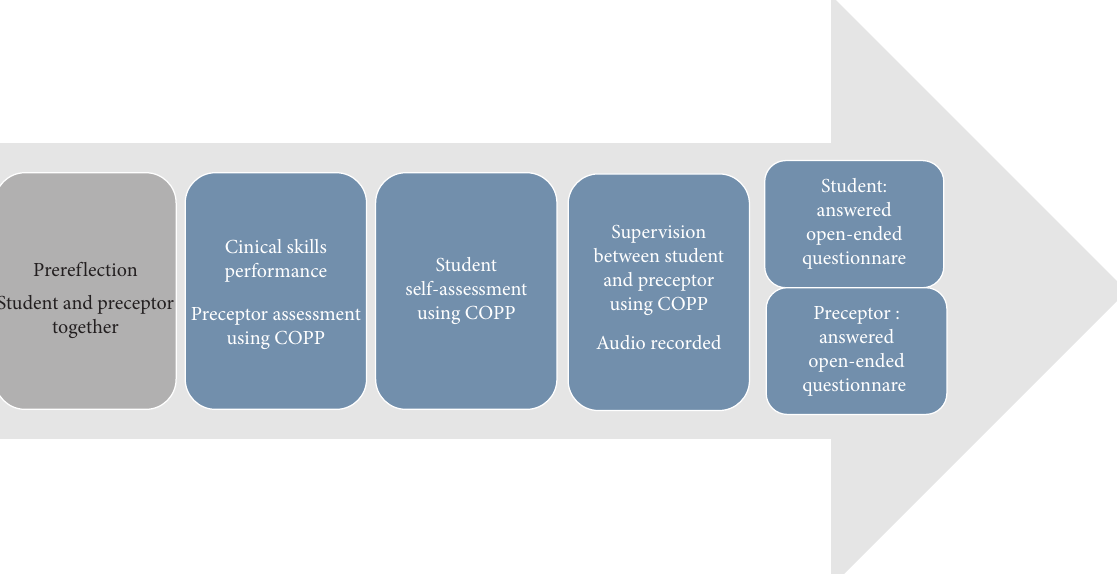
Figure 1: Data collection and supervision of one student’s clinical